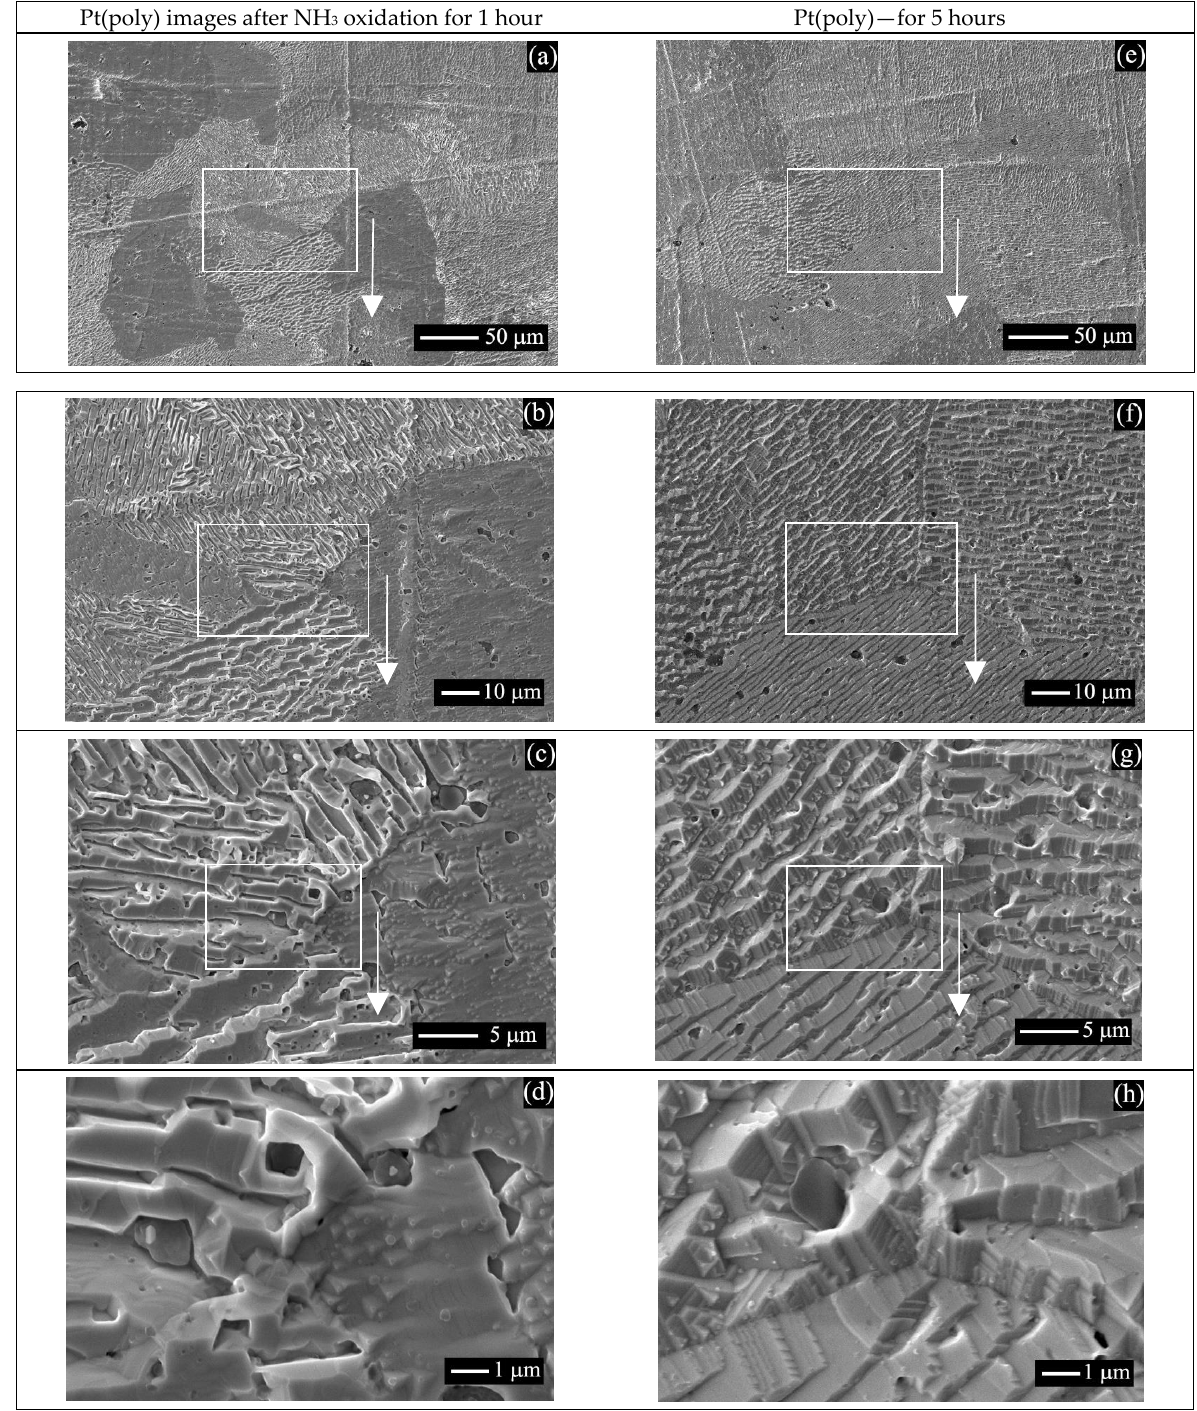
Figure 4. SEM images of the Pt(poly) surface after NH 3 oxidation with air oxygen at T = 1133 K for 1 ( a – d ) and 5 ( e – h ) hours. Images were obtained in SE mode at E 0 = 20 keV; rectangles indicate the regions represented by images with a higher magnification. After NH 3 oxidation for 5 h, a granular structure with a grain size of 50 – 100 µm is (d–f) after NH 3 oxidation at 1133 K for 1 (a,d), 5 (b,e) and 10 (c,f) hours according to